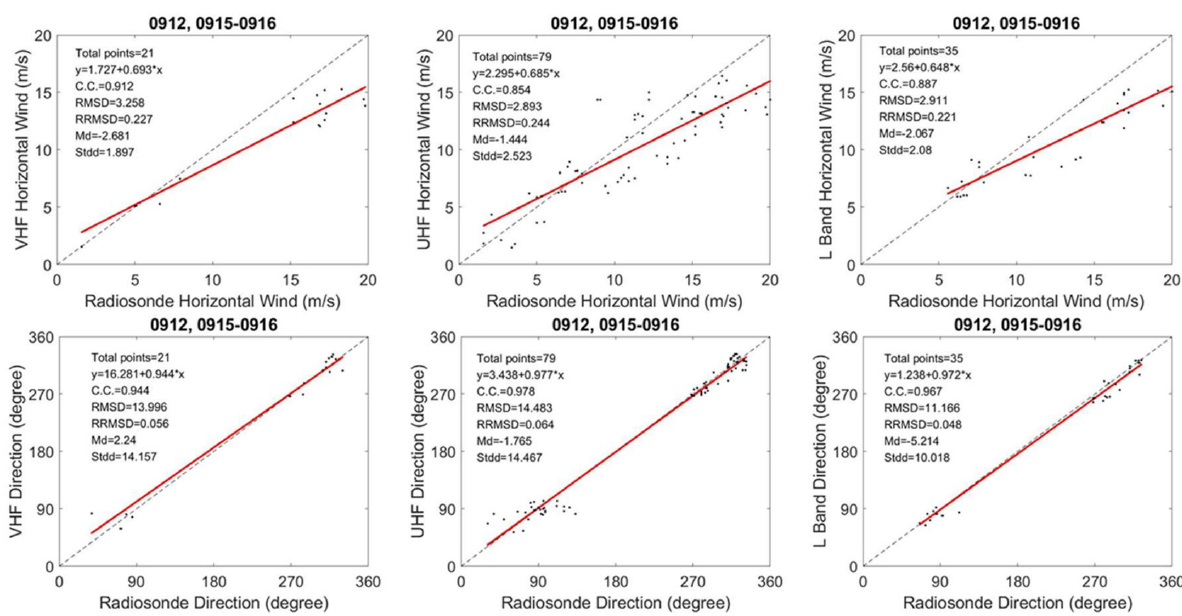
Figure 8. Comparison of horizontal wind velocities ( upper panels) and wind directions ( lower panels) between wind profiler and radiosonde measurements in clear air conditions. The dashed black line is the diagonal line, and the solid red line is the linear fit to the